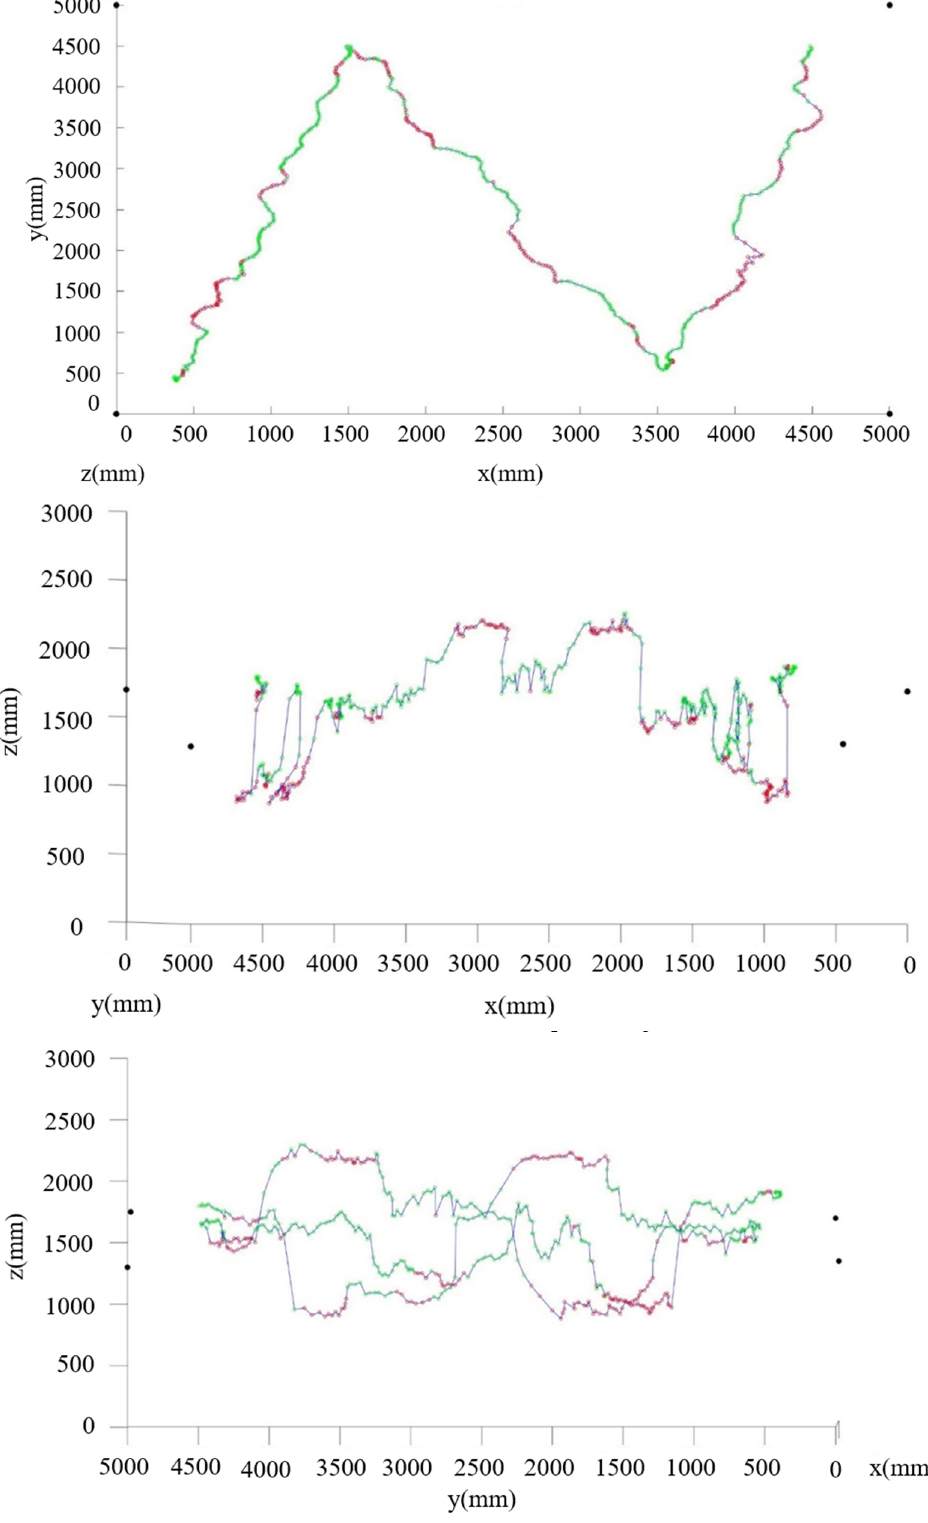
Figure 16. The movement track of the target. ( a ) Movement track of target point on XOY plane; ( b ) Movement track of XOZ plane target; ( c ) Movement track of YOZ plane